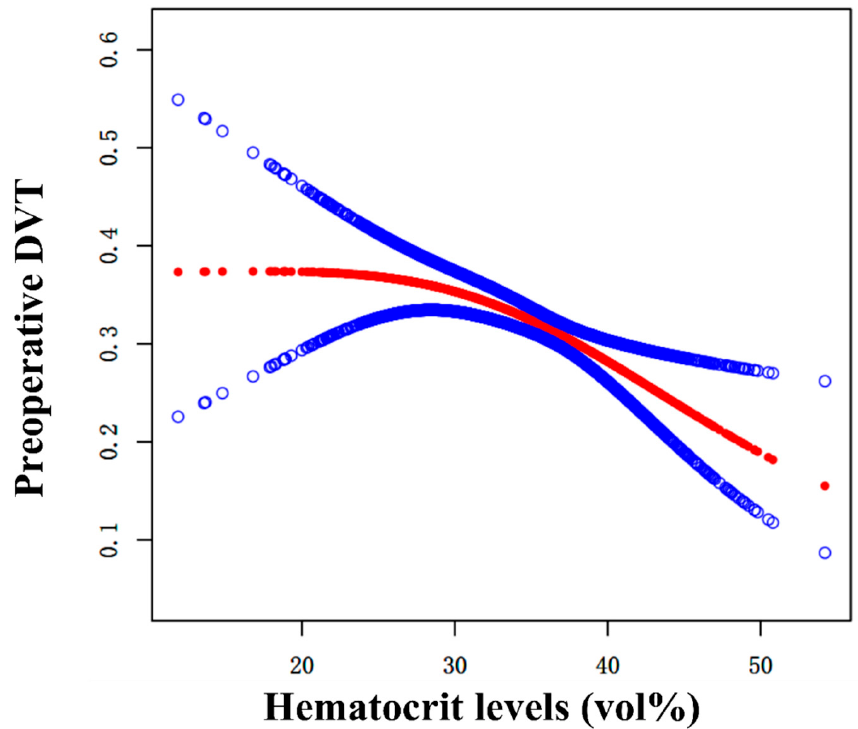
Table 4. Nonlinearity of admission hematocrit levels versus preoperative DVT (N=1840). Outcome: